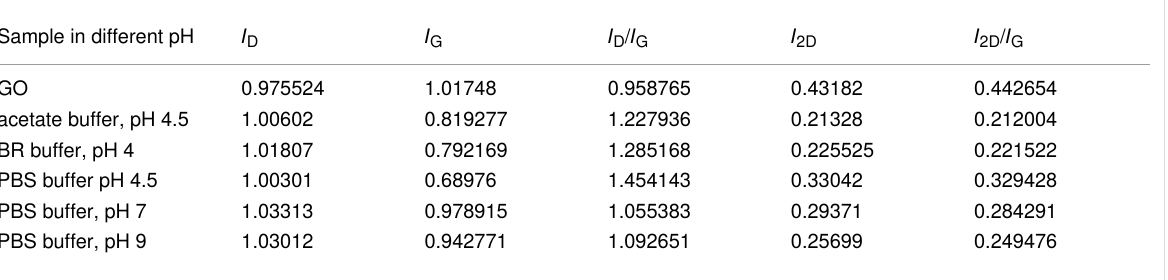
Table 1: Experimental sample table showing variation of Raman peak intensity ratio of ERGO using different